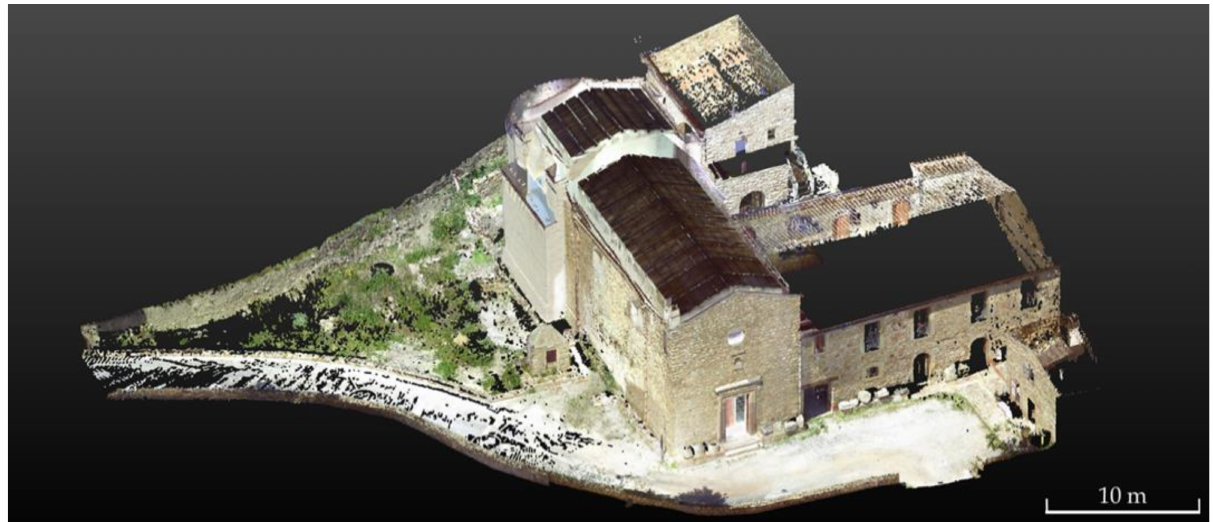
Figure 9. Isometric view of the 3D dense cloud, after the alignment and cleaning